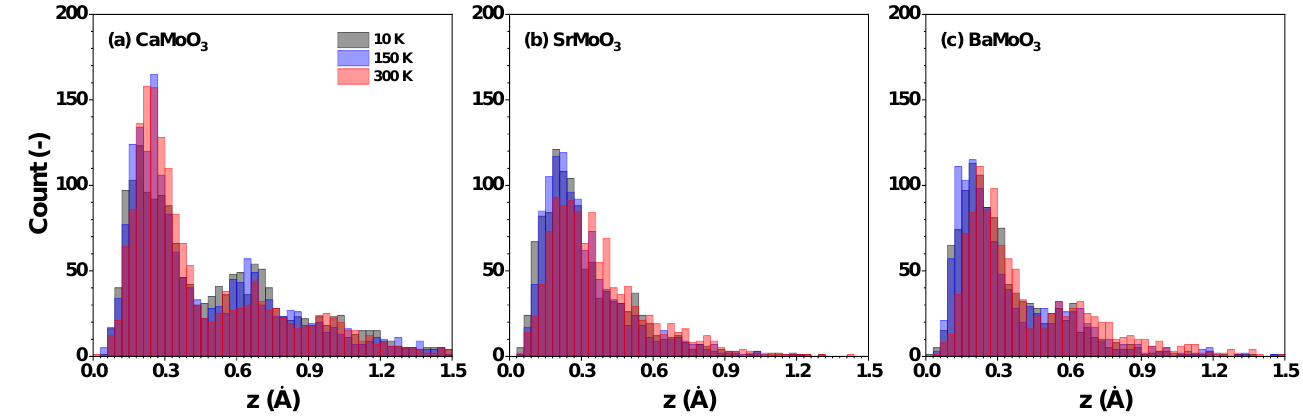
Figure 8. Histograms of calculated ζ values (Equation (1)) describing the stretching distortion of [MoO 6 ] octahedra in polycrystalline ( a ) CaMoO 3 , ( b ) SrMoO 3 , and ( c ) BaMoO 3 at 10 K, 150 K, and 300 K. See text for details.